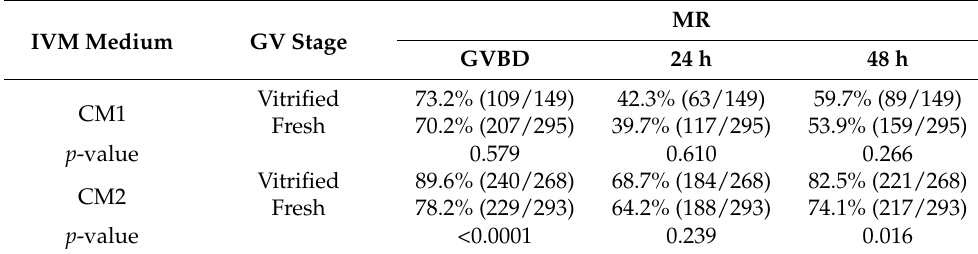
Table 2. Maturation rates (MRs) evaluated in relation to the maturation medium used for each of the groups studied: GV vitrified and GV fresh. The MRs in relation to germinal vesicle breakdown (GVBD) after 24 h (24 h) and 48 h (48 h) in culture. CM1, IVF medium; CM2, CCM supplemented medium. Average percentages relative to the groups and p -value.